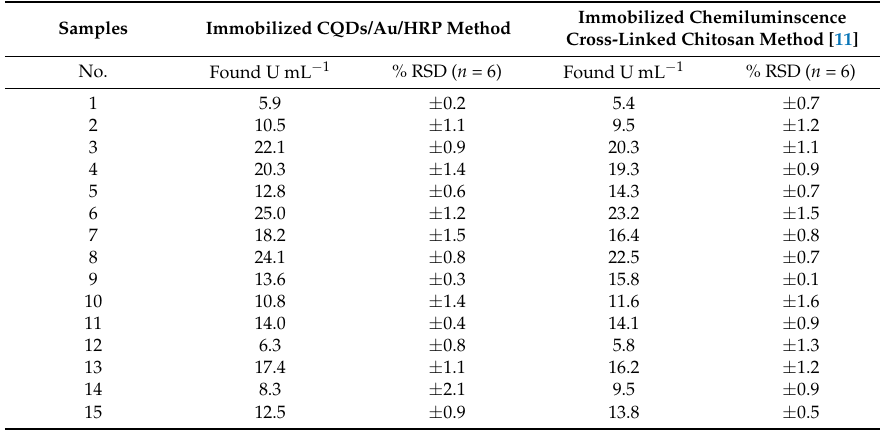
Table 2. Comparative analytical results obtained from the analysis of 15 serum samples